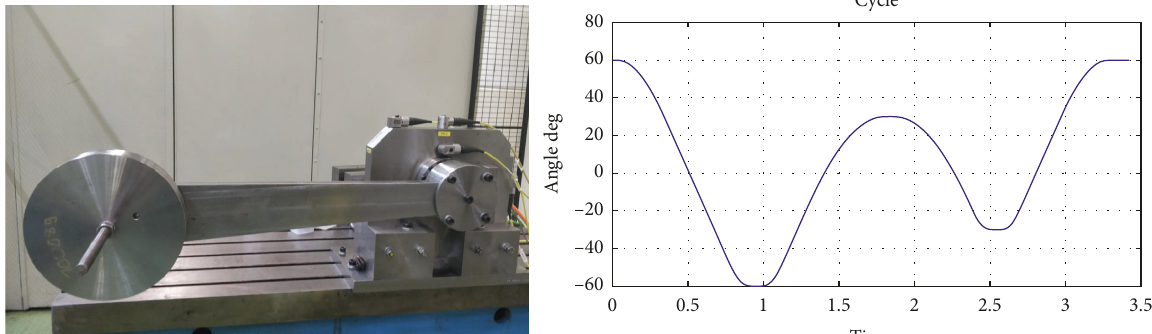
Figure 6: Gearbox setup (a). Operating cycle (b).